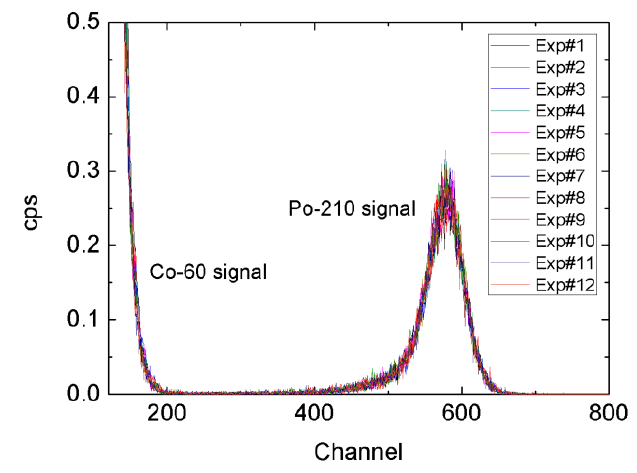
Fig. 7. The alpha spectra of the total of 12 repeated experiment that performed at 10-minute intervals